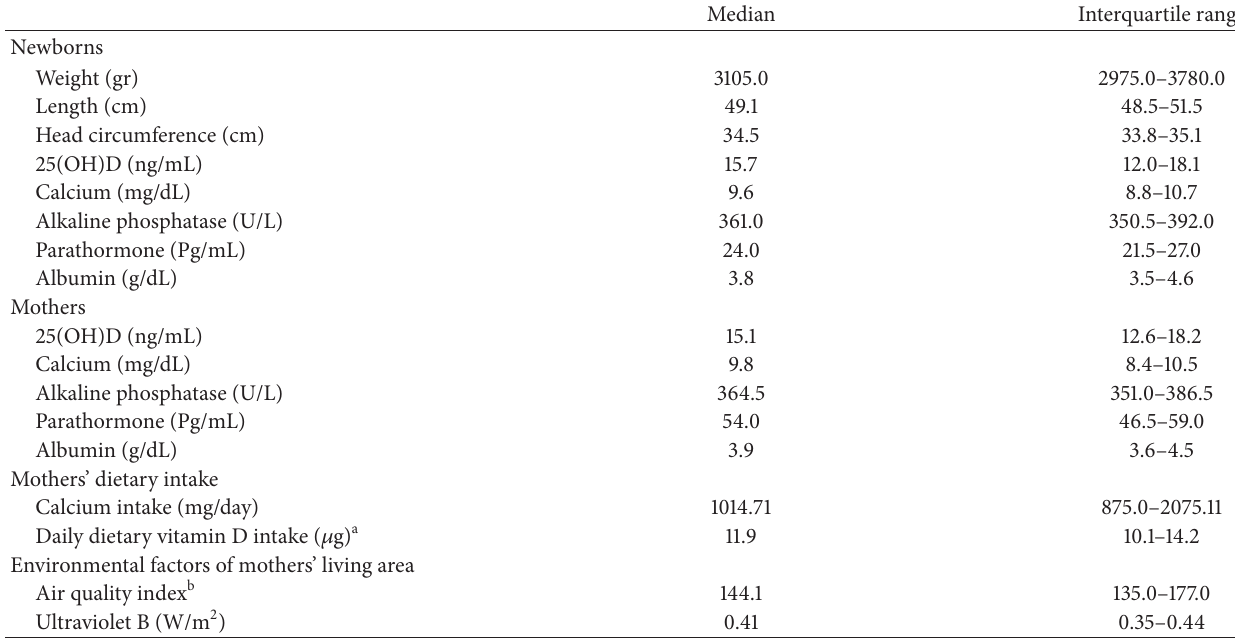
Table 1: General characteristics of variables